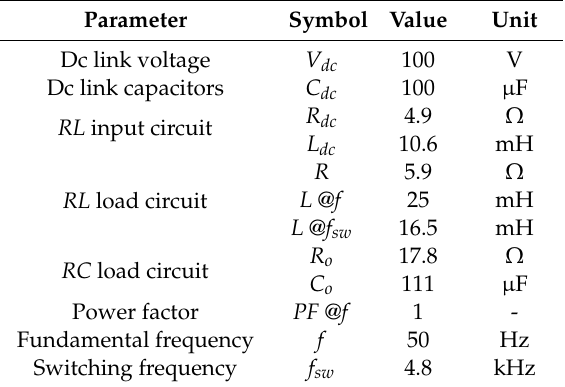
Figure 15. ( a ) Experimental laboratory test bench; ( b ) Unity power factor load. Table 1. Experimental setup parameters.